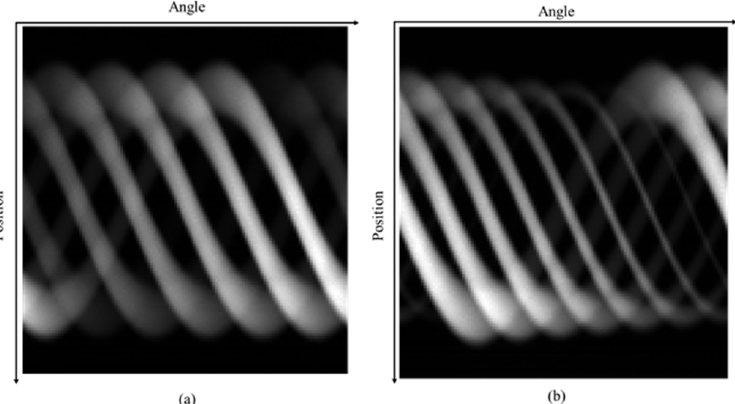
Figure 9. The sinograms acquired by Monte Carlo simulation. ( a ) is the sinogram of phantom A and ( b ) is the sinogram of phantom B .